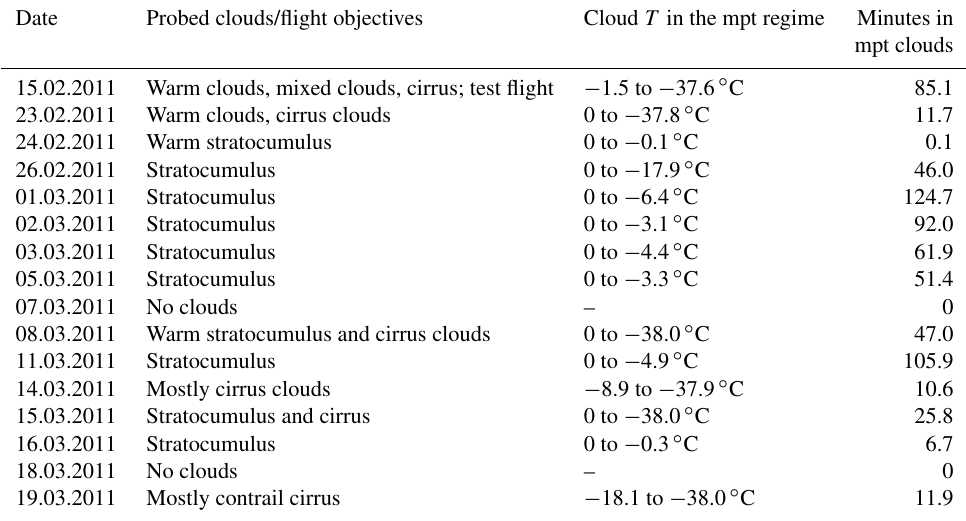
Table 2. Flight table for COALESC. Dates are dd/mm/yyyy. Date Probed clouds/flight objectives